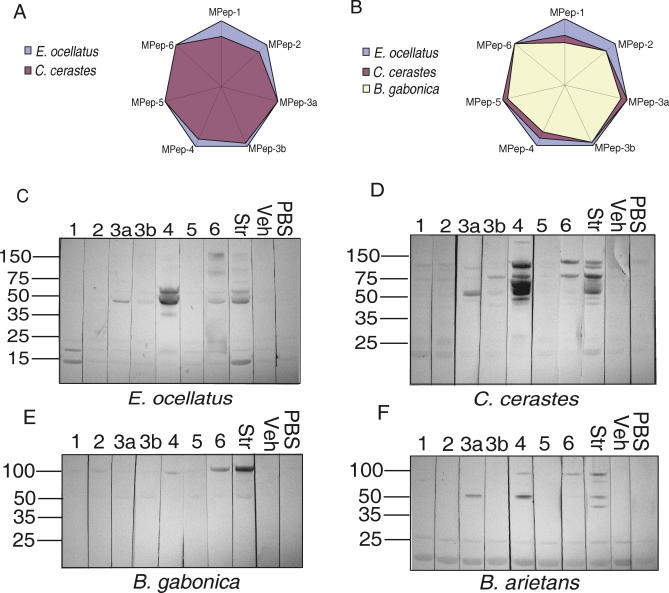
Prediction and Experimental Verification of the Immunological Conservation of EoMPep 1–6 in Phylogenetically Distinct African Viper Species(A and B) The immunological conservation of EoMPep 1–6 is predicted using radar charts comparing the percentage highest bit score results generated by BLAST searches of EoMPep 1–6 against the
E. ocellatus venom gland EST database (VgDbEST) (taken as 100%) with BLAST searches against VgDbEST databases from (A)
C. cerastes (SCW, unpublished data, 2006) and (B) the latter and
B. gabonica [
35].
(C–F) Experimental assessment of immunological cross-reactivity using pooled sera raised against EoMPep 1–6 as individual MAPs (indicated as numerals 1–6 above each blot) and EoSVMP string (Str) following nonreduced immunoblotting of whole venom of four viper species (indicated below each blot). Molecular mass markers are shown to the left. Veh, pVaxSec DNA vehicle control.